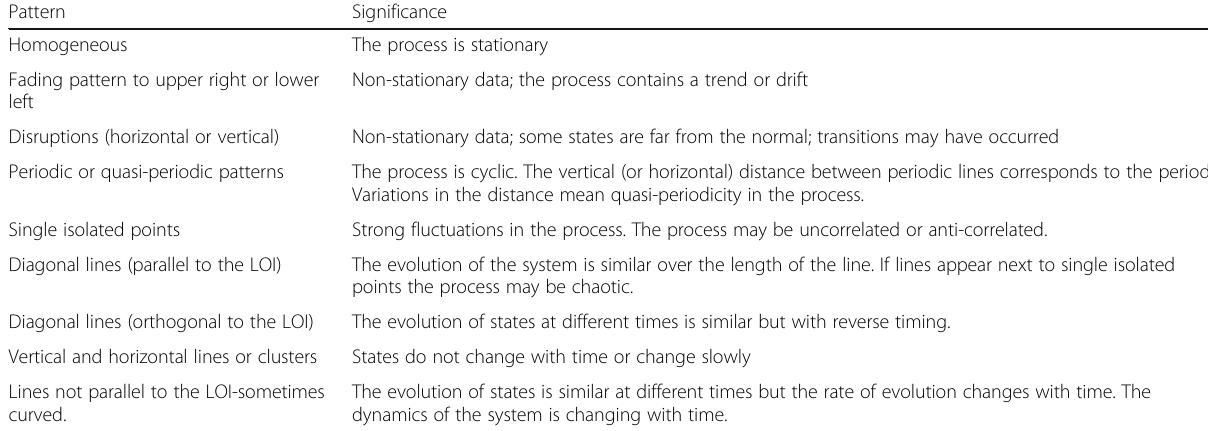
Table 2 Significance of patterns in recurrence plots (after Marwan et al. 2007a) Pattern